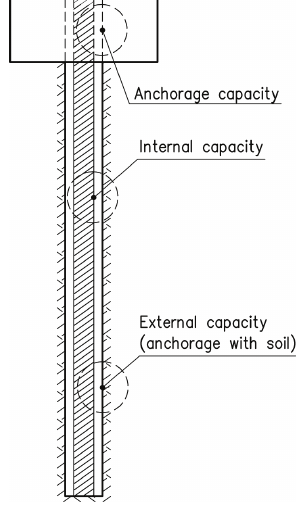
Fig. 2. Foundation-pile-soil connection surface